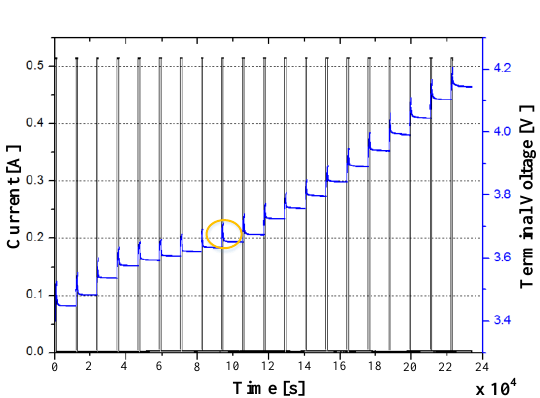
Figure 3. Current and voltage waveforms of the lithium-ion battery during the pulse charge test.